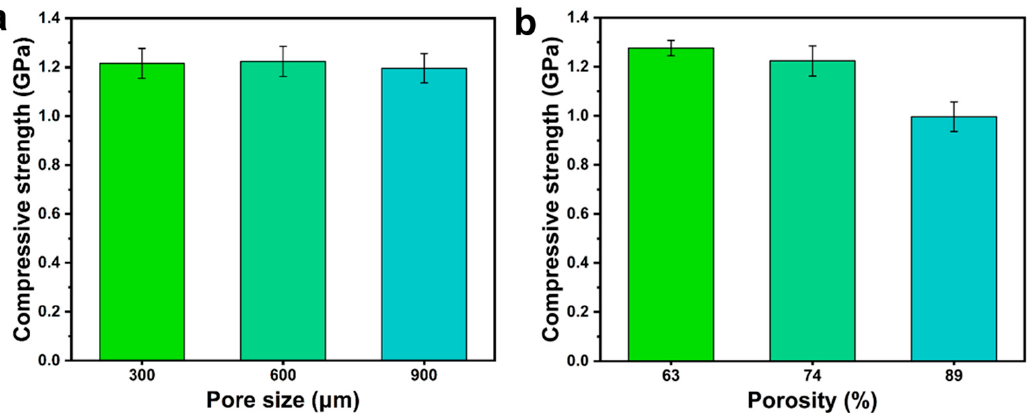
Figure 2. ( a ) Compressive strength of PLA scaffolds (74% porosity) with different pore sizes, ( b ) Compressive strength of PLA scaffolds (600 μ m) with different porosity.